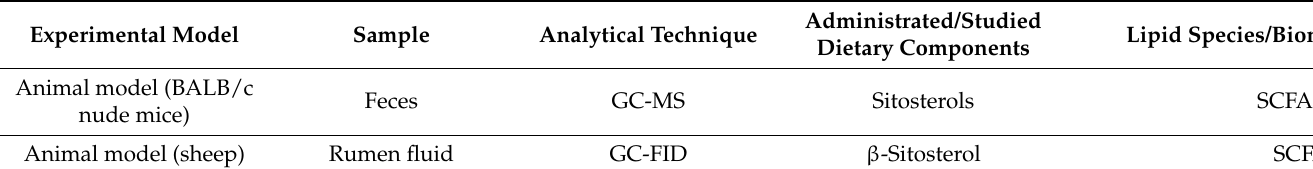
Table 3. Up-to-date lipidomic status of exogenous or endogenous